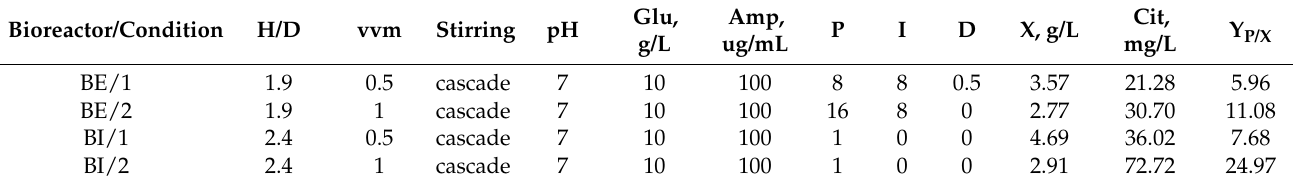
Table 2. Selected conditions used to produce cyt b5 by E. coli TB-1 cells in the bioreactors BE and BI.